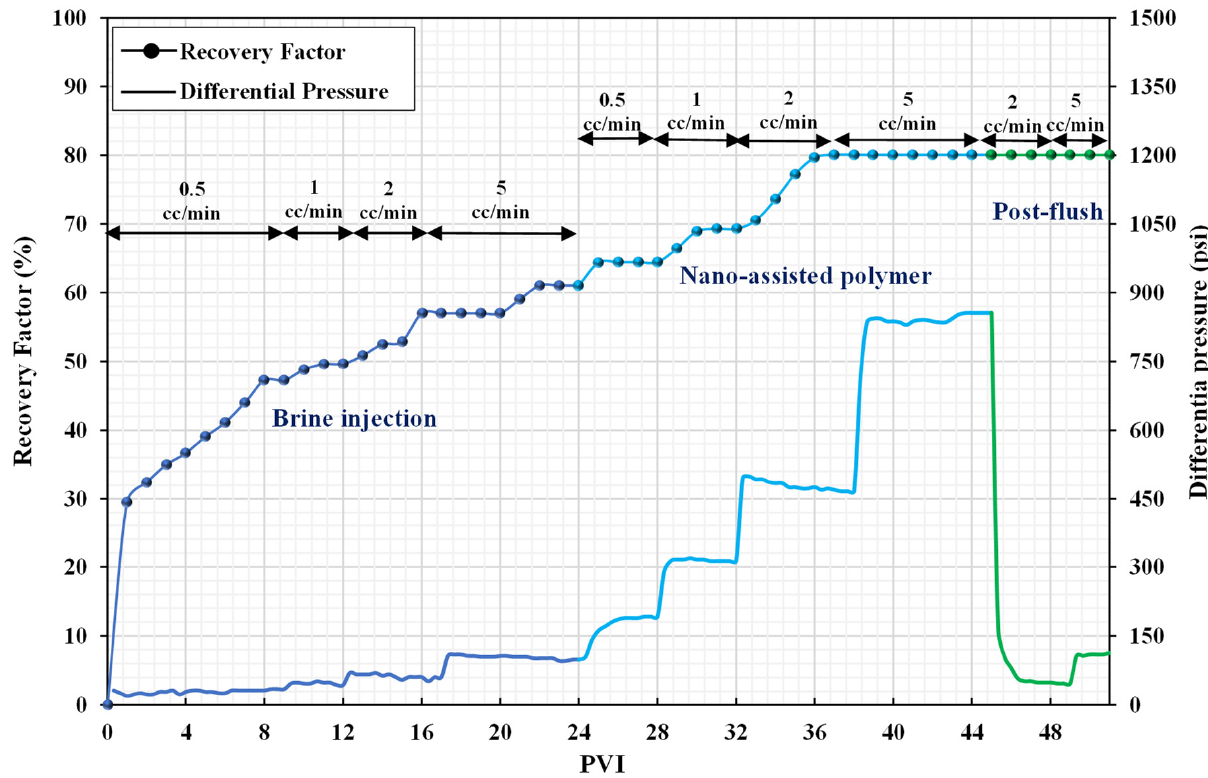
Figure 10. Recovery factors and differential pressure versus PVI (coreflood-4).